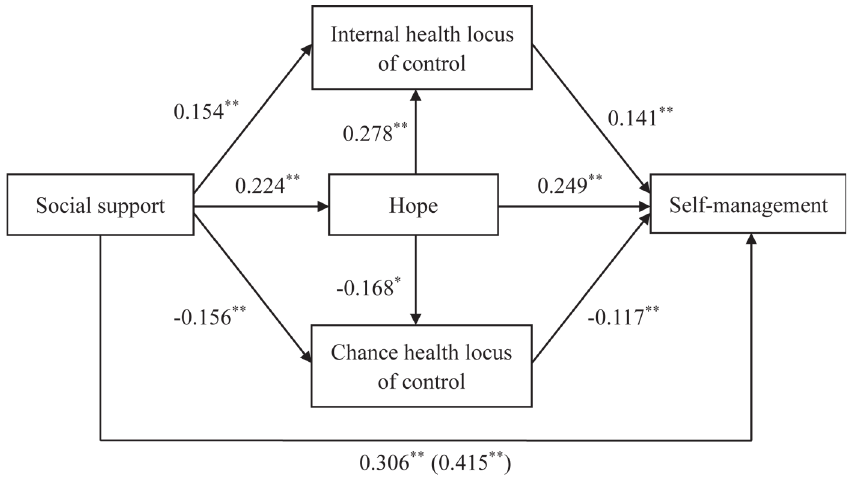
Table 3. Correlation analysis among study variables ( r ).